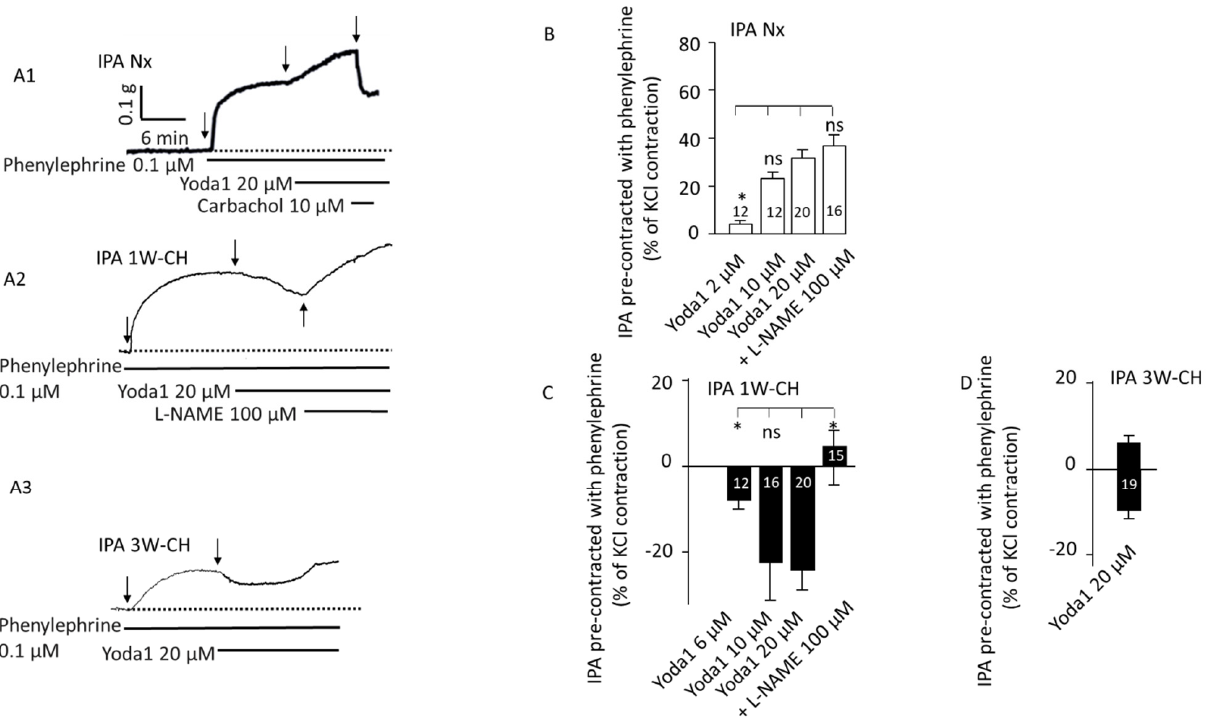
Figure 4. Piezo1 activation relaxes pre-contracted IPA from the early stage of PH. On pre-contracted IPA (phenylephrine 0.1 µ M), Piezo1 contracted Nx IPA but relaxed 1W-CH IPA. ( A ) Typical trace of IPA tension recorded in the presence of Yoda1 on Nx ( A1 ), 1W-CH ( A2 ), or 3W-CH ( A3 ). For Nx IPA, application of carbachol induced a relaxation, indicating a functional endothelium. For 1W-CH IPA, direct application of L-NAME (100 µ M) converted the relaxation to a contraction, pointing out the importance of EC Piezo1 in the release of NO. Following 3W-CH, note the biphasic response (relaxation then contraction). ( B ) Statistical analysis of the contraction induced by Yoda1 (2–20 µ M) in Nx IPA. ( C ) Amplitude of the Yoda1-mediated relaxation in 1W-CH pre-contracted IPA. In the presence of L-NAME (100 µ M), Yoda1 induced a contraction instead of relaxation. ( D ) Effect of 20 µ M Yoda1 in 3W-CH IPA (amplitude of the relaxation then contraction). * p < 0.05. The number inserted in the bar graph represents the number of arterial rings analyzed. Vertical arrow represents the beginning of the drugs’ application. ns=not significant. Minimum four different rats, at least four rings per rat were